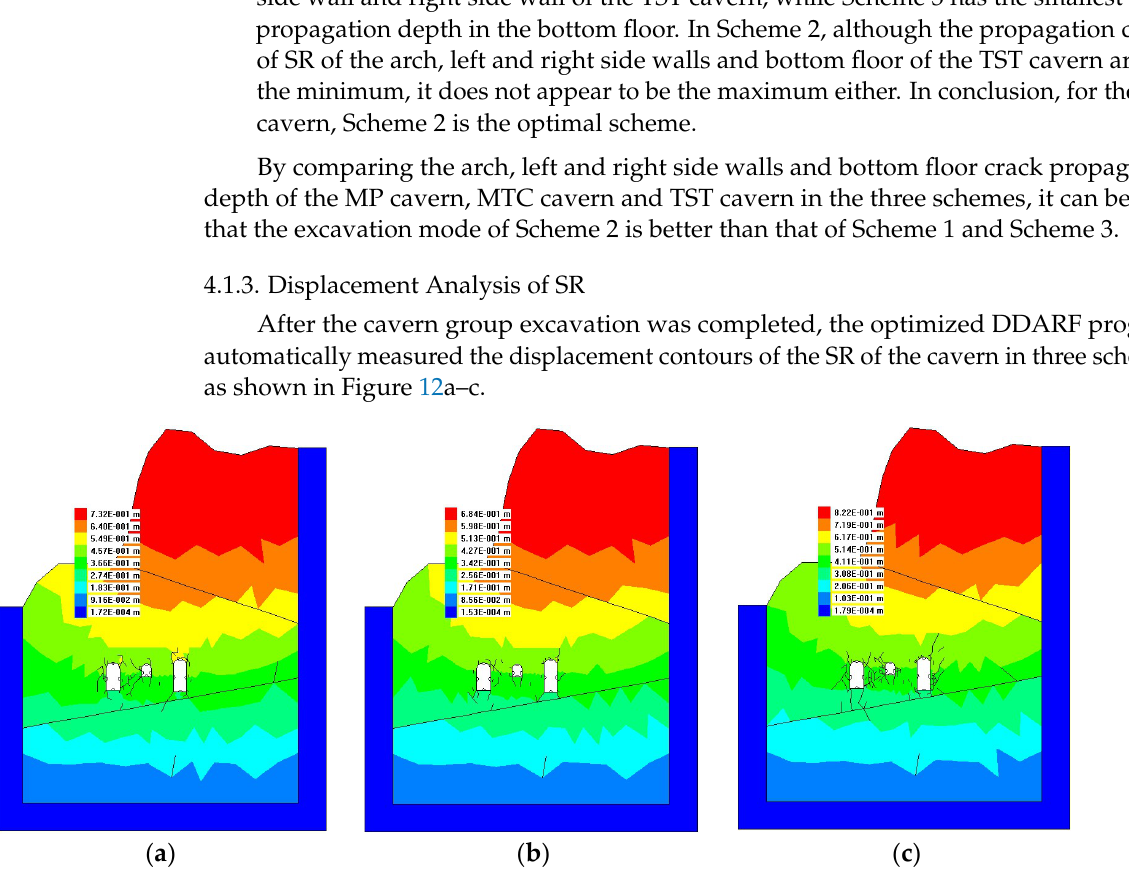
Figure 12. Displacement contours of three schemes after excavation completion: ( a ) Scheme 1; ( b ) Scheme 2; ( c ) Scheme 3.